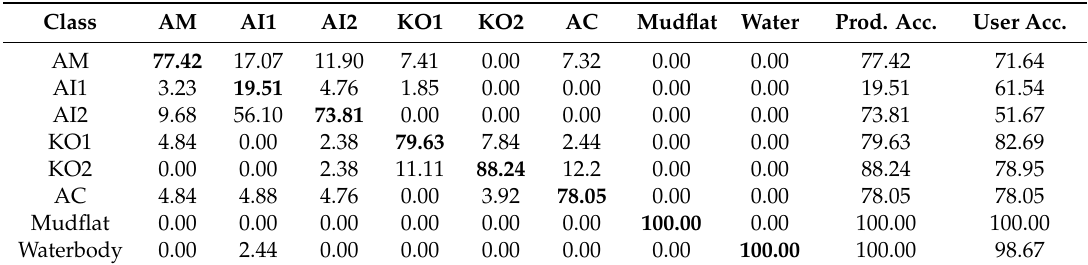
Table 4. Confusion matrix calculated from SVM + OS classification results.